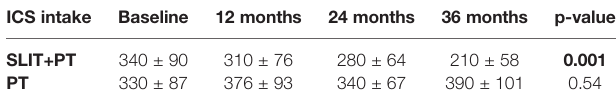
TABLE 2 | Decrease in ICS intake after 3 years of AIT.